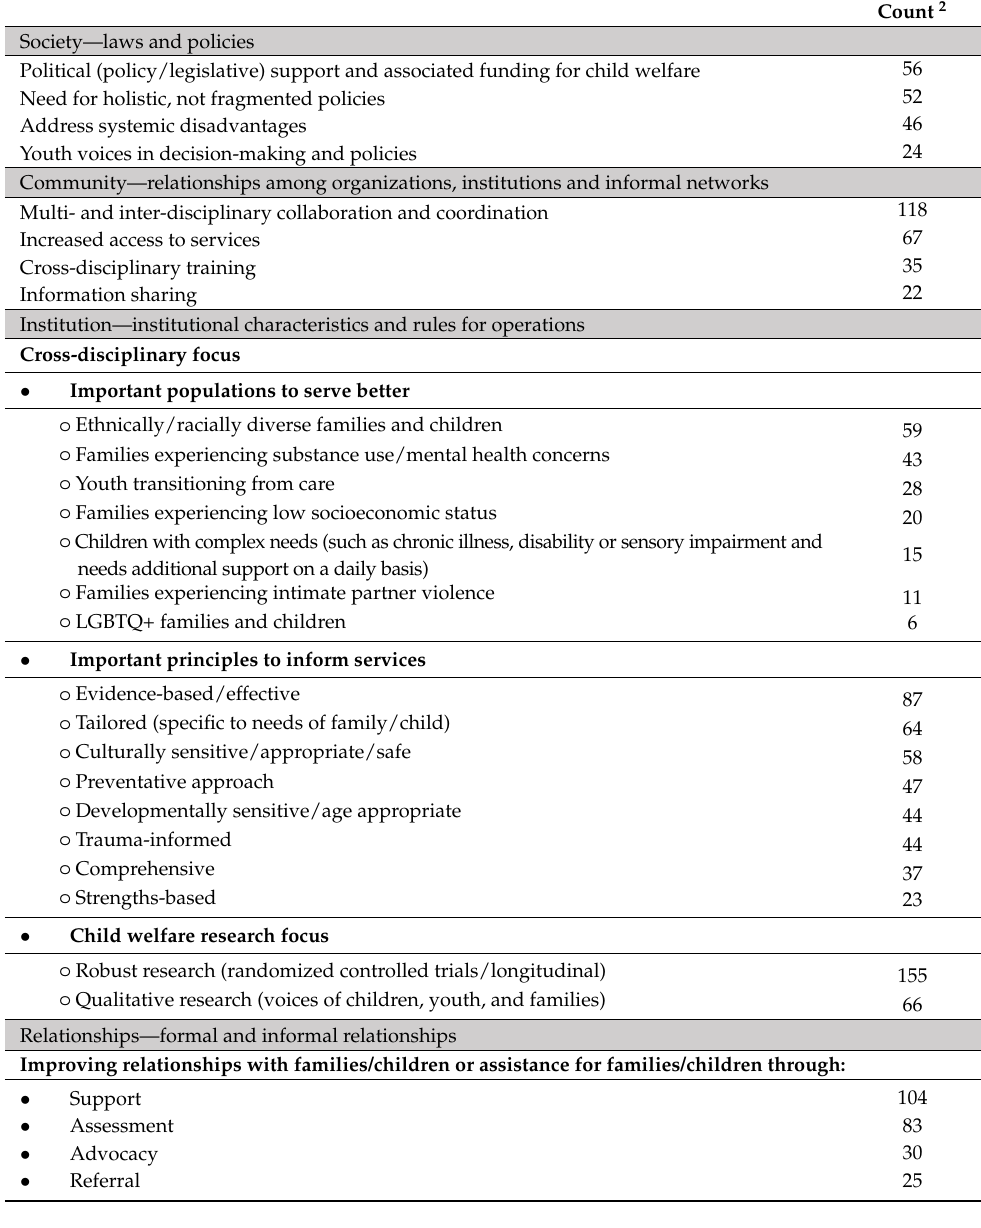
Table 5. Thematic Focus of Included Articles. 1 Table 6. Authors’ Recommendations for Improving Child Welfare Across Socioecological Levels. 1